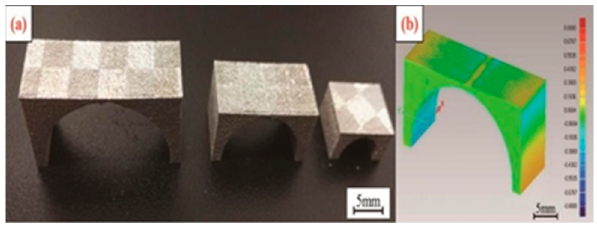
Figure 10. 316L Bridge model made by SLM: ( a ) A sample of a bridge-shaped structure; ( b ) the deformation diagram [76].